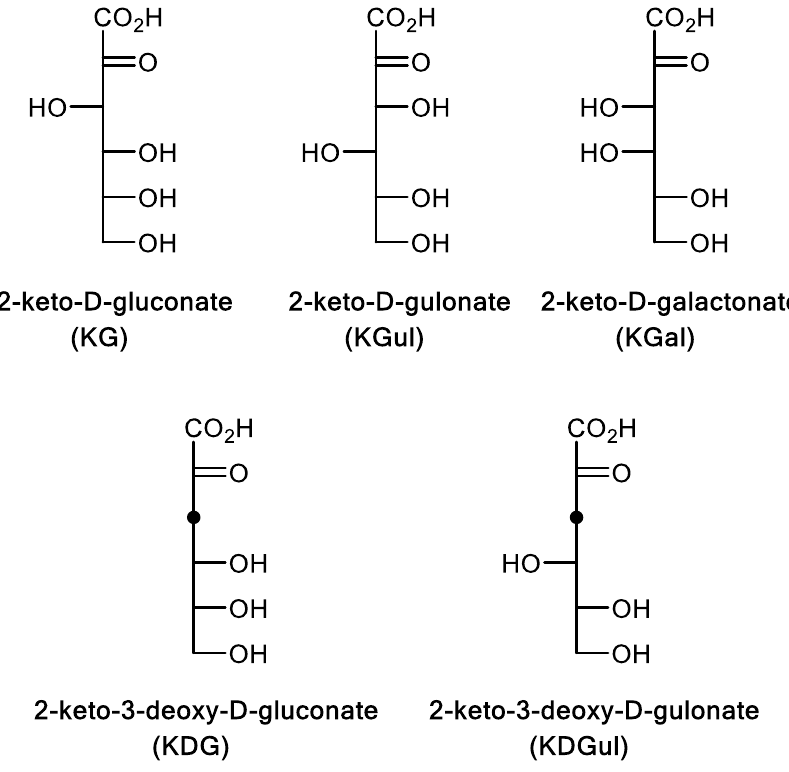
Figure 4. 2-keto - carboxylic acid sugars tested as KGUK Cnec substrate.